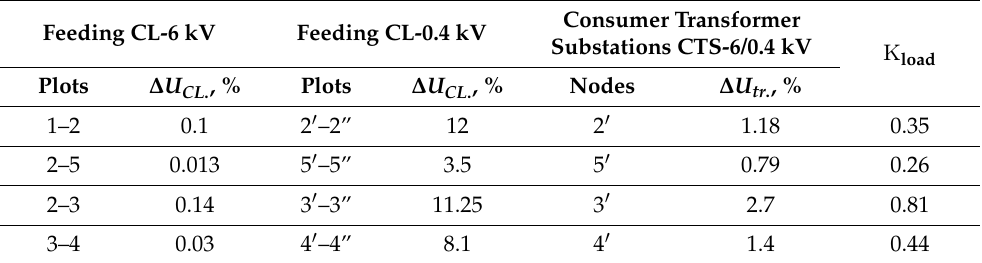
Table 3. Computation results of voltage losses and load coefficients of a 6/0.4 kV consumer trans- former substation.